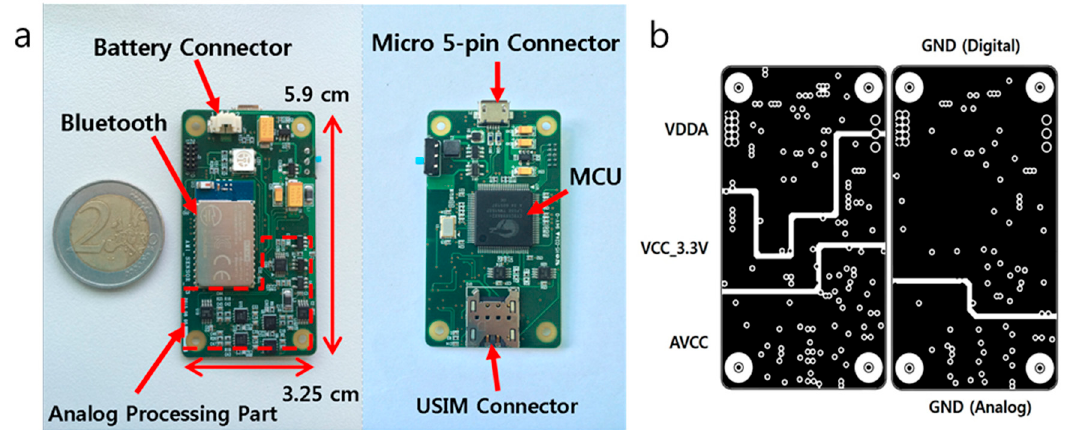
Figure 1. ( a ) PCB of miniaturized amperometric analyzer; ( b ) Scheme of the ground and power layer.